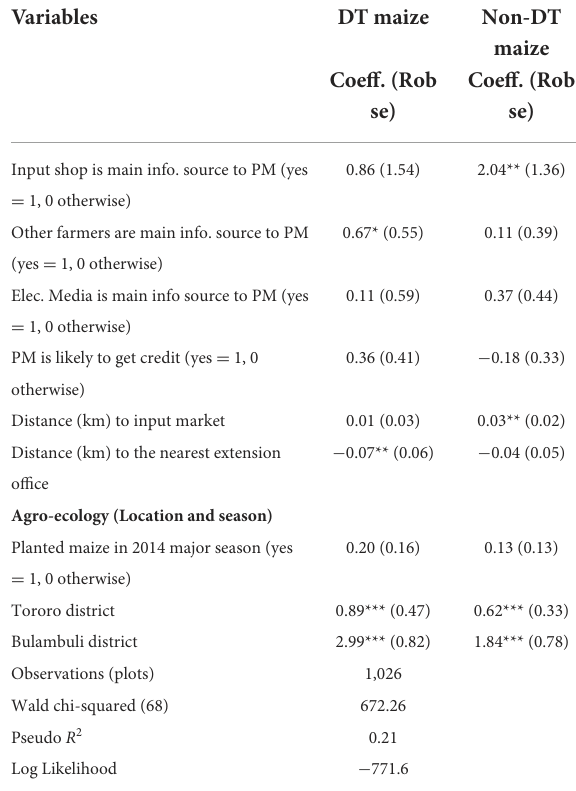
TABLE 3 Parameter estimates of the determinants of DT and non-DT maize adoption-multinomial logit selection model (Local maize as base